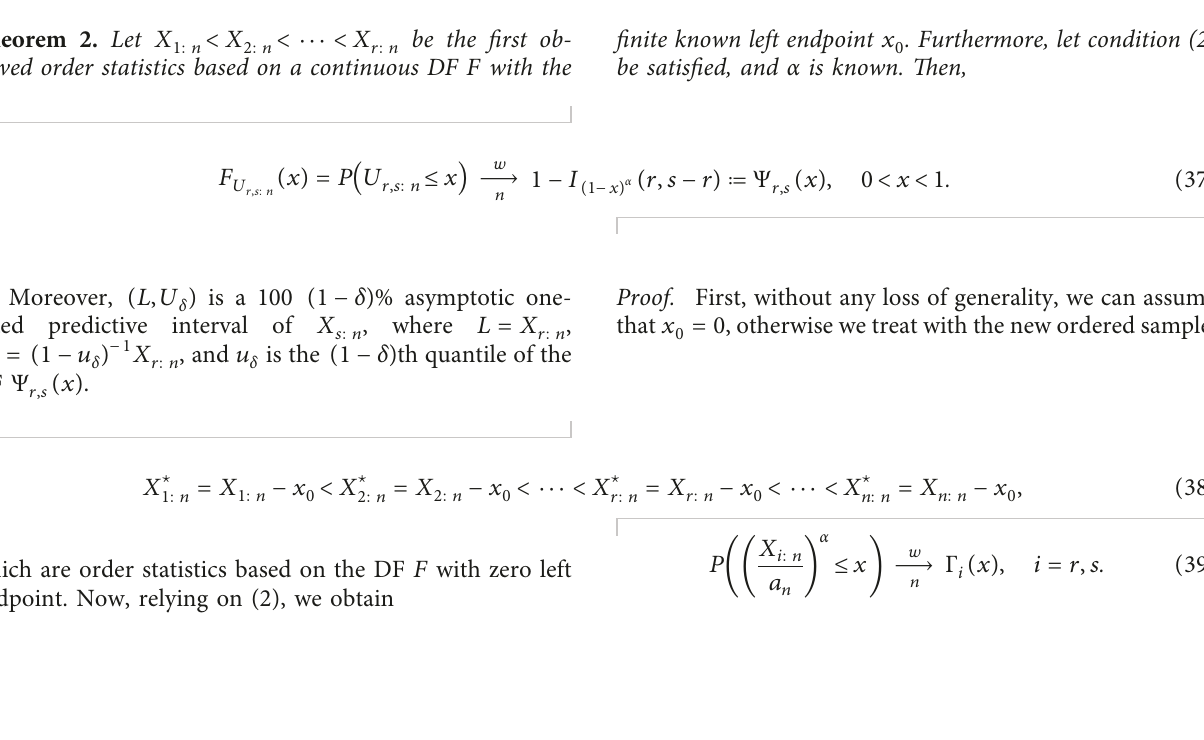
Table 4: Comparisons between α ⋆ and 􏽥 α via Pitman’s measure of closeness for different values of r . r 2 3 ( α ⋆ , 􏽥 α P 0